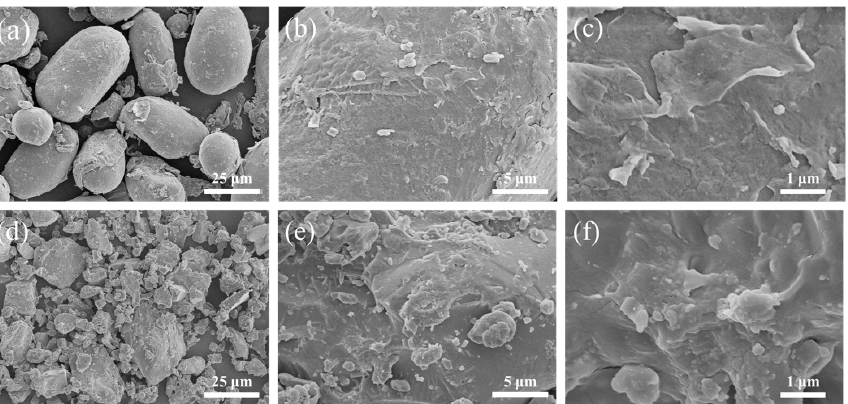
Figure 2. Scanning electron microscope images of PPS and CMCS. ( a ) PPS × 1000; ( b ) PPS × 5000; ( c ) PPS × 20,000; ( d ) CMCS × 1000; ( e ) CMCS × 5000; ( f ) CMCS × 20,000. CMCS was obtained by carboxymethylation when the mass ratio of m NaOH :m MCA :m PPS was 1:1:2 and